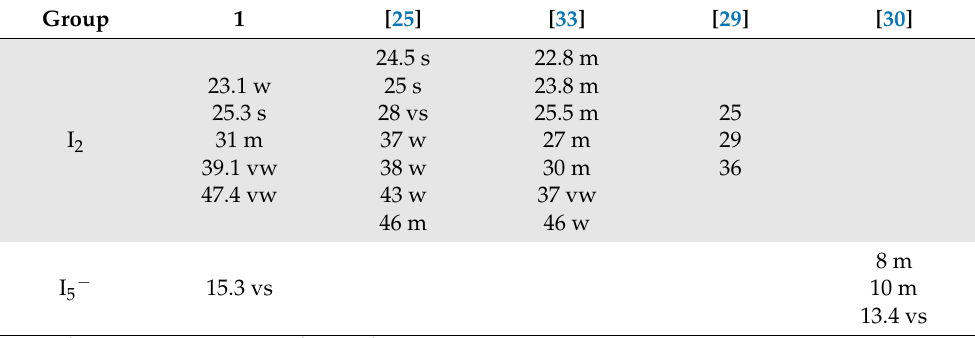
Table 5. The XRD analysis of the samples [Cu(12-crown-4) 2 ]I 5 (1), pure I2 [25], and previous reports